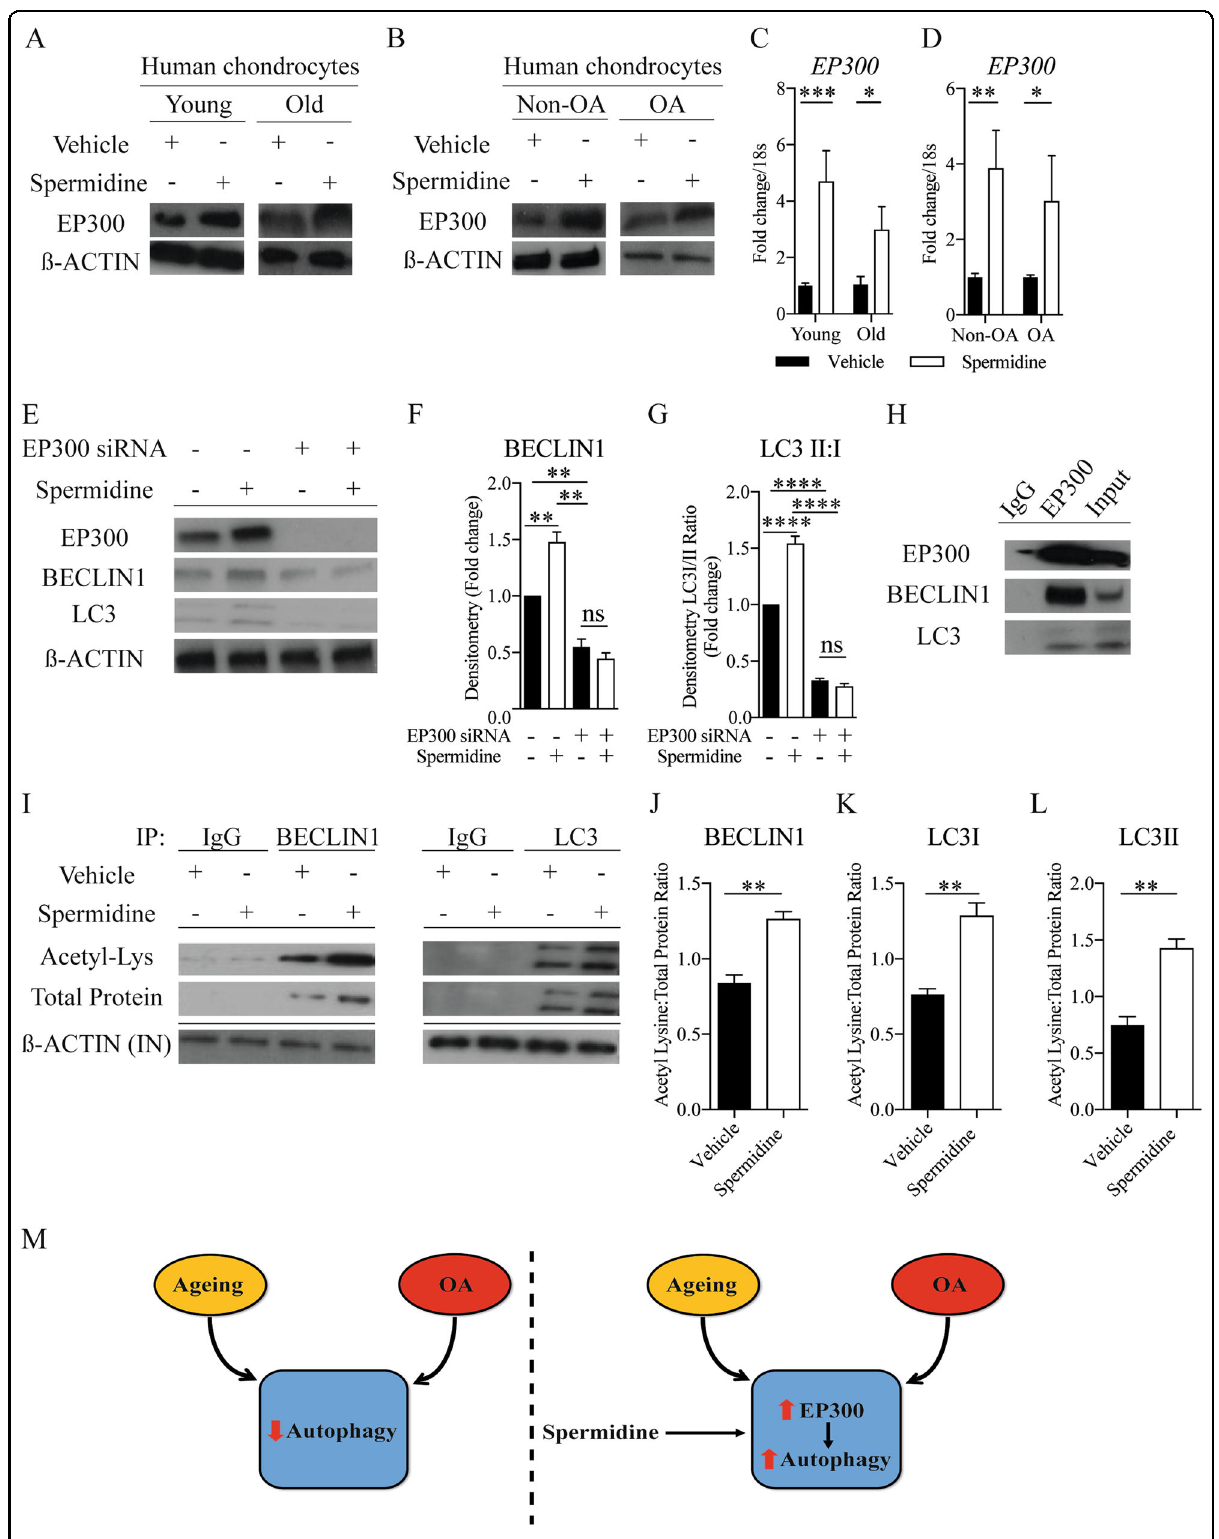
Fig. 4 (See legend on next